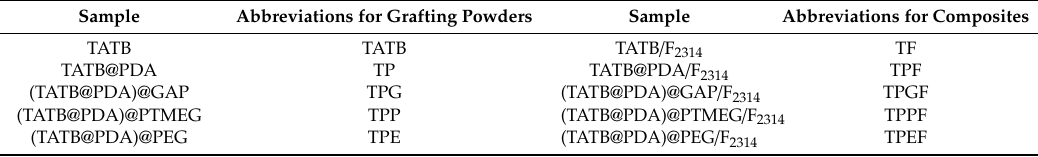
All of the abbreviations for the modified 1,3,5-triamino-2,4,6-trinitrobenzene (TATB) samples. PDA—polydopamine; GAP—glycidyl azide polymer; PEG—polyethylene; PTMEG— polytetramethylene ether glycol; F 2314